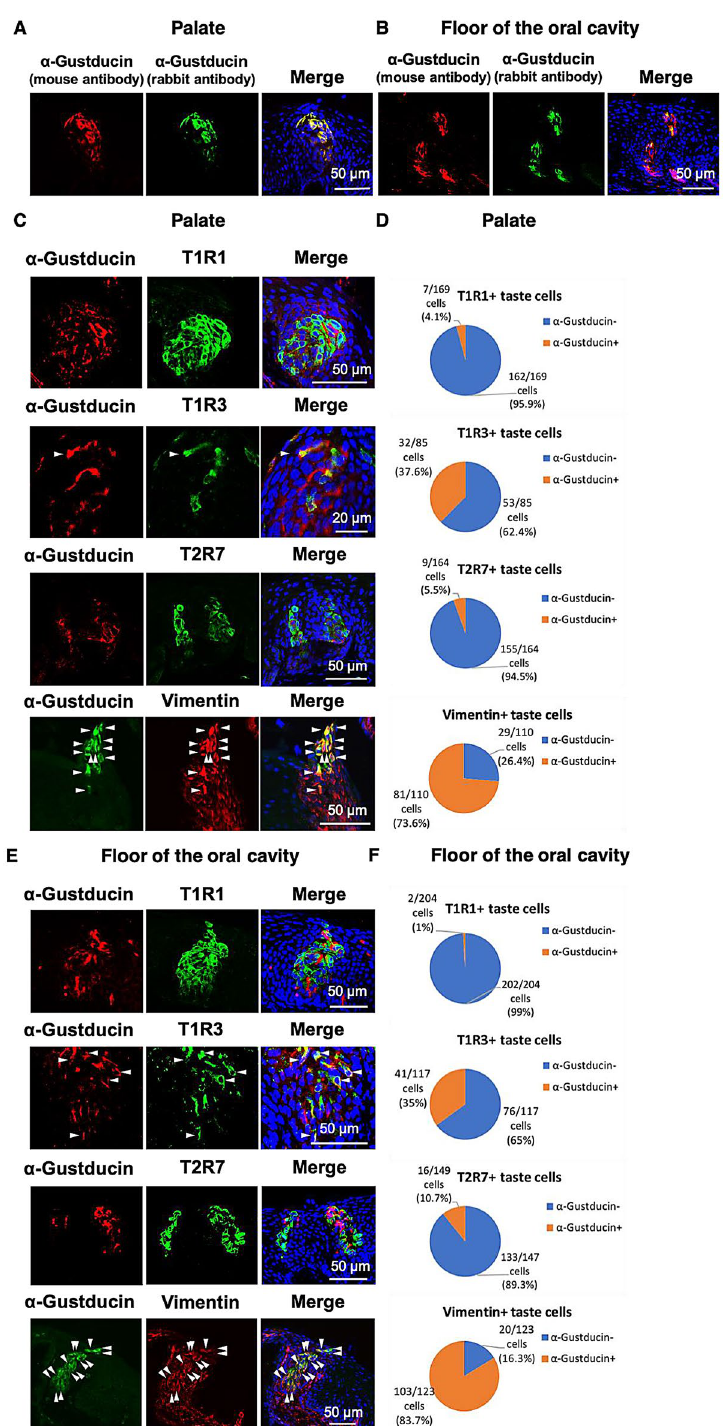
Figure 2. ( A , B ): The distributions of α-gustducin, labeled by the antiserum generated herein (host species: mouse) ( red ) and α-gustducin, labeled by the antiserum (host species: rabbit) ( green ) immunosignals in the oral tissues in the palate (A) or floor of the oral cavity (B) of 7-day-old chickens. Nuclei were stained with DAPI ( blue ). ( C , E ): The distributions of α-gustducin ( red ) and T1R1, T1R3, or T2R7 ( green ) immunosignals or α-gustducin ( green ) and vimentin ( red ) immunosignals in the oral tissues in the palate (C) or floor of the oral cavity (E) of 7-day-old chickens. Arrowheads: Taste bud cells labeled by both α-gustducin and T1R3 or both α-gustducin and vimentin. Nuclei were stained with DAPI ( blue ). The images were representative and 9 (T1R1), 20 (T1R3), 10 (T2R7), and 16 (vimentin) images were analyzed respectively. ( D , F ) Ratio of α-gustducin + cells and α-gustducin − cells in the T1R1 + , T1R3 + , T2R7 + , or vimentin + taste bud cells in the palate ( D ) and floor of the oral cavity ( F